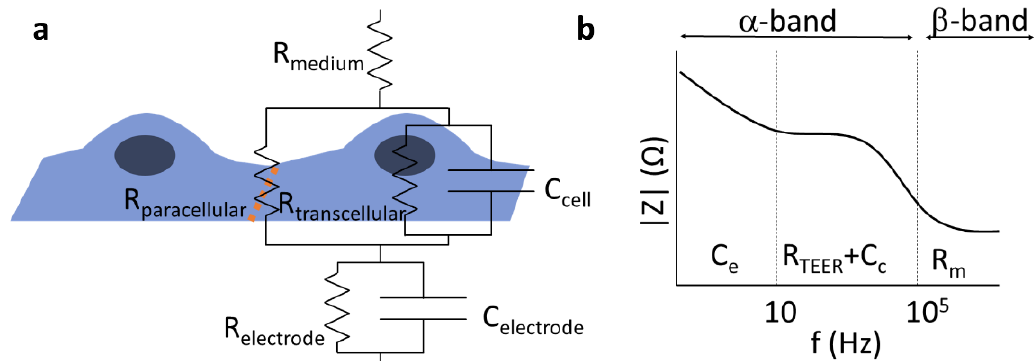
Figure 1. Components of the total electrical impedance measured across brain endothelial cells modeling the blood–brain barrier. ( a ) The equivalent circuit of a cell monolayer. The transendothelial resistance (R TEER ) is primarily dominated by the paracellular resistance (R paracellular ). In the case of electrical impedance measurement, the transcellular pathway (R transcellular , C cell ) and the properties of the electrode (R electrode , C eletrode ) also affect the recorded signal. The orange dotted line depicts tight junctions between brain endothelial cells. ( b) Schematic impedance spectrum of a cell monolayer. The α -band contains the electrode polarization, the resulting resistance of the layer (R TEER , determined by the para- and transcellular resistances: R paracellular and R transcellular ), and the capacitance of the cell layer (C c ), while the β -band is dominated by the resistance of the medium (R m ) and the resulting capacitance of the system. Modified from [5].